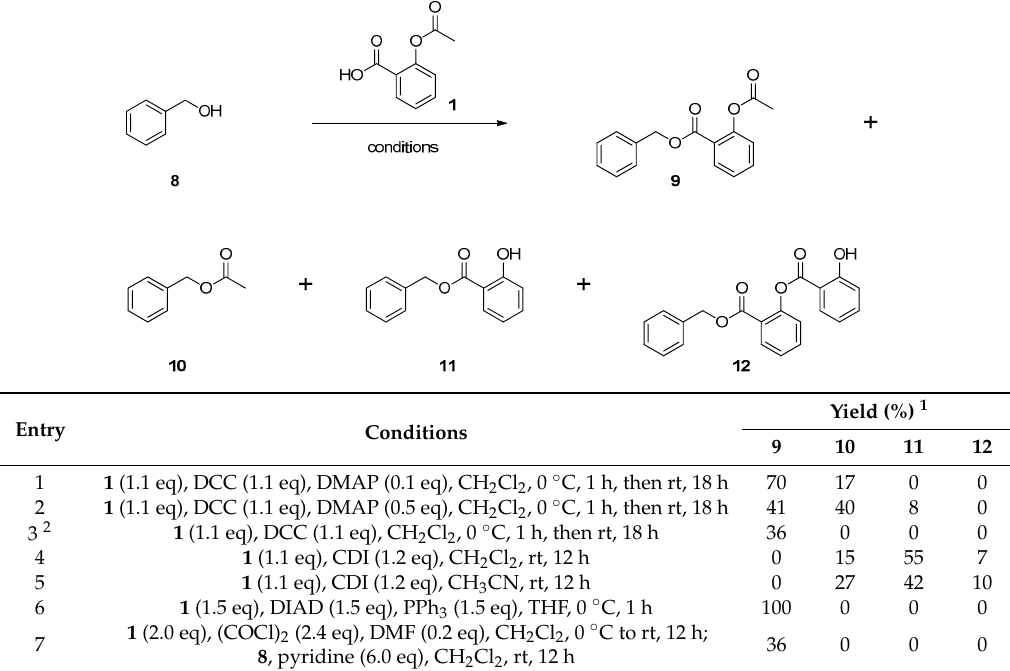
Molecules 2016 , 21 , 1126 Table 2. Aspirinate ester formation of benzyl alcohol under general esterification conditions.